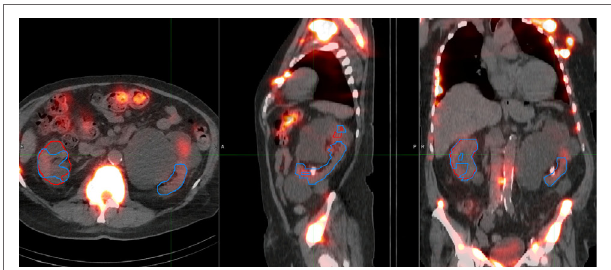
FigUre 7 | Most challenging case encountered in testing the renal convolutional neural networks. Due to multiple large cysts in originating within the central renal structure, the segmentation tool detected only 20 cc of the manually contoured 167 cc left kidney volume (dice =